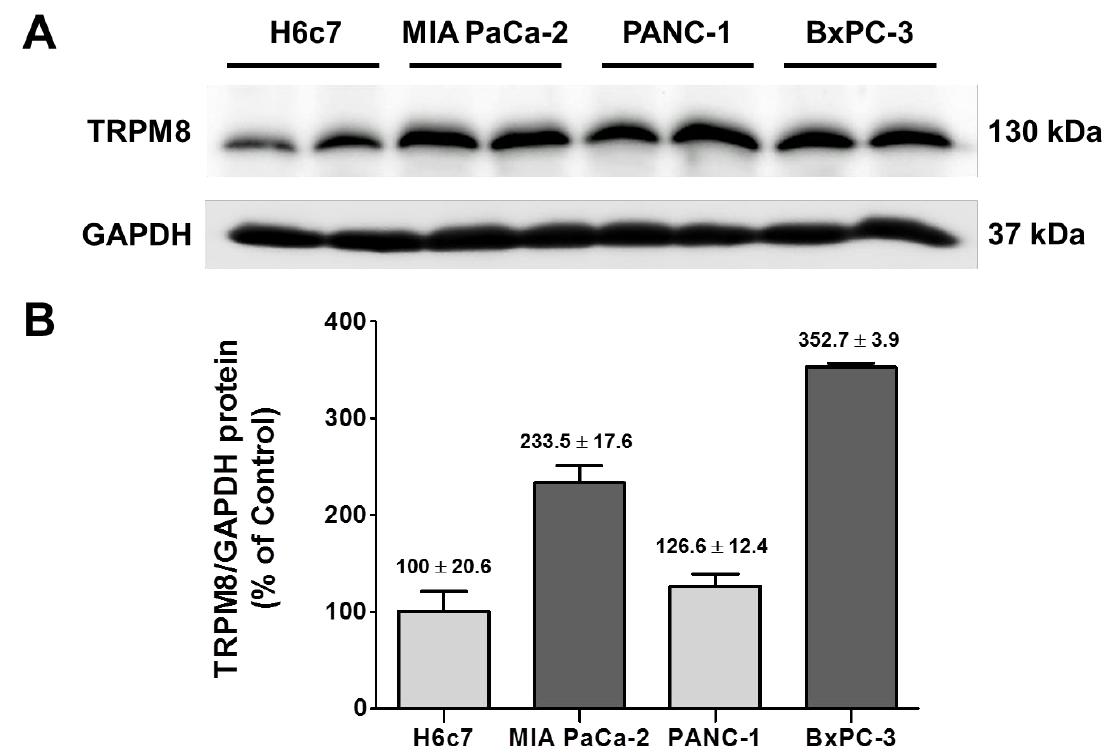
Figure 5. Over-expression of TRPM8 protein in human pancreatic adenocarcinoma cell lines. ( A ) The protein levels of TRPM8 in H6c7, MIA PaCa-2, PANC-1, and BxPC-3 cells were determined using immunoblotting with anti-TRPM8 antibodies. The GAPDH protein levels were analyzed as internal controls. ( B ) The relative protein levels of TRPM8 are expressed as % (mean ± standard error) of that in